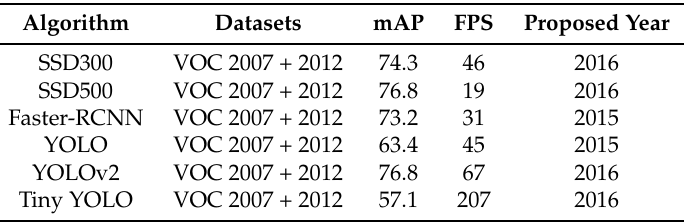
Table 1. The performance of the